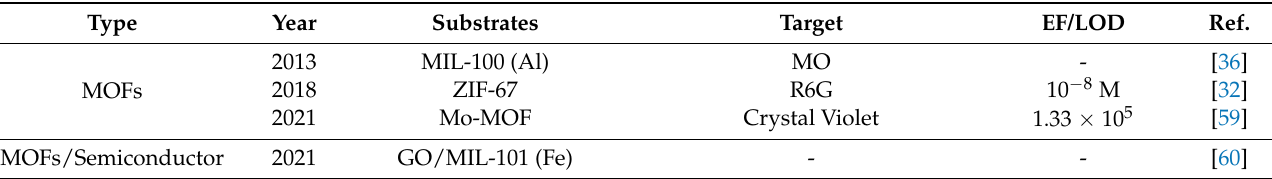
Table 1. Research progress on different types of